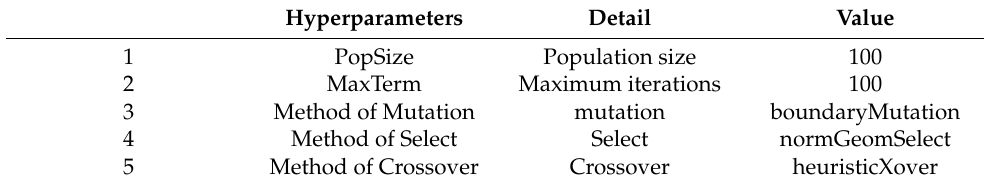
Table 6. GA hyperparameter settings.